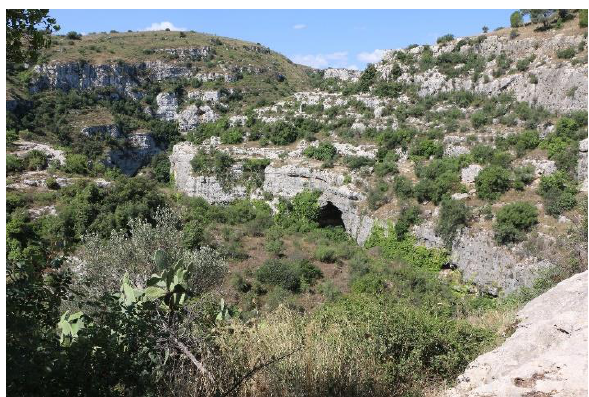
Figure 3. View of Calcinara valley; in the background, the entrance of Grotta dei Pipistrelli The cavity has a sub-horizontal development with a 7.3% WE average slope and it has been explored for about 260 m, between the entrance of the cave (234 m a.s.l.) and the ending point (253 m a.s.l.), where a thick layer of detritus blocks the duct. At the entrance (Fig. 4), the cave has a large opening that quickly shrinks into a funnel leading into a first